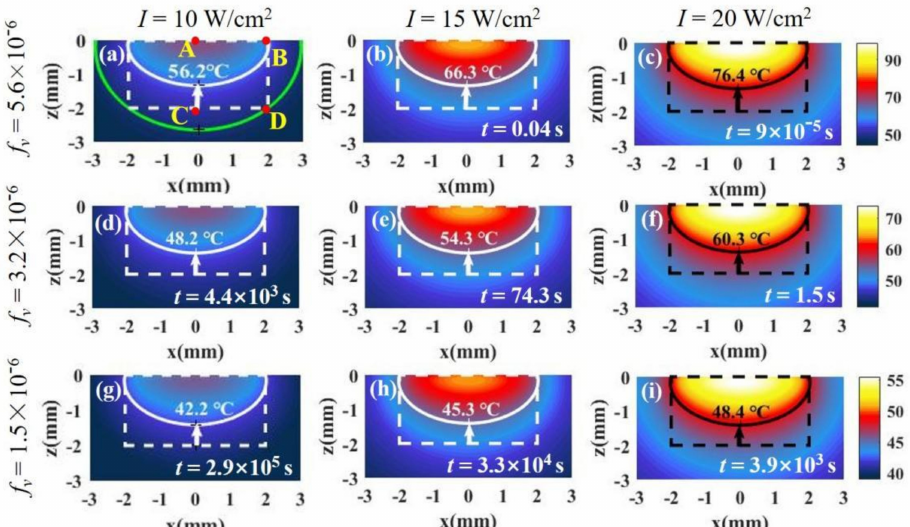
Figure 4. The temperature distributions of tissue and the surrounding environment under different laser intensities and SNP volume fractions. Both tumor depth and radius are 2 mm ( R T = 2 mm, z = 2 mm). The tumor tissue is in the dotted frame, and healthy tissue is outside of the frame. In ( a ), the white solid line is isotherm through point B, and the green solid line is isotherm through point D. Time t is the minimum time required to make tissue undergo permanent damage at the isotherm temperature. The laser intensities and SNP volume fractions in ( a – i ) are shown on the top and left of the figure,